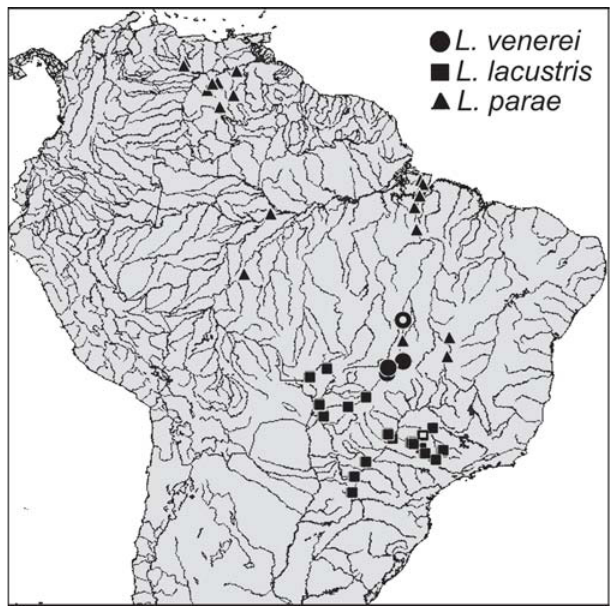
Fig. 2. Map of South America, showing the distribution of Leporinus venerei (dots), Leporinus parae (triangles) and Leporinus lacustris (squares); open symbols indicates type-